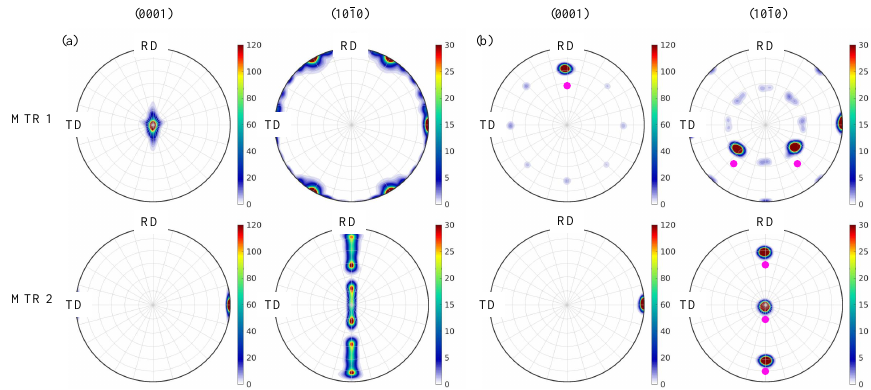
Figure 6. Mesoscale pole figures of each MTR after compression ( T = 1172 K, ε = 0.51). ( a ) ND compression; ( b ) 45 ◦